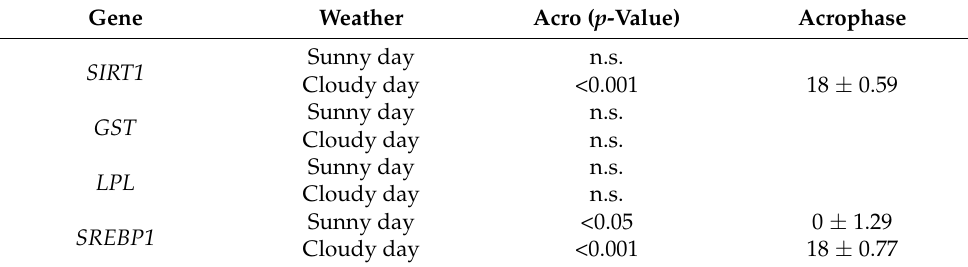
Table 5. Cosinor analysis board for metabolic genes expression under the sunny and cloudy conditions.